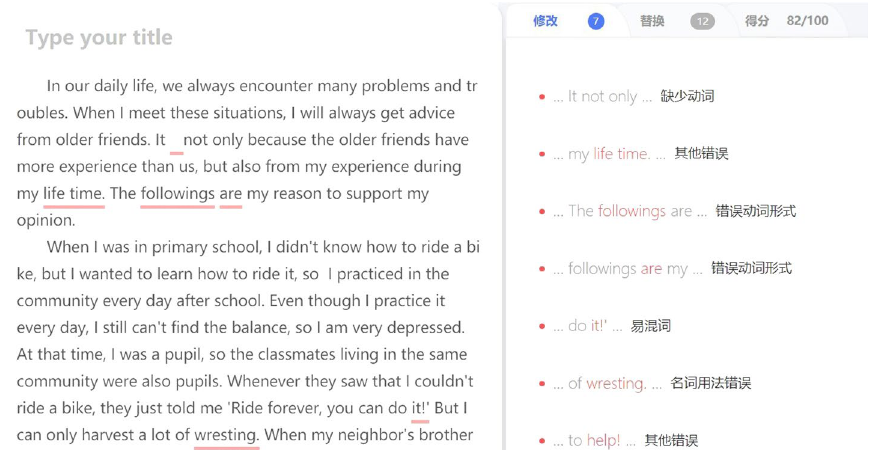
Fig. 2 Feedback from Aim Writing for the same